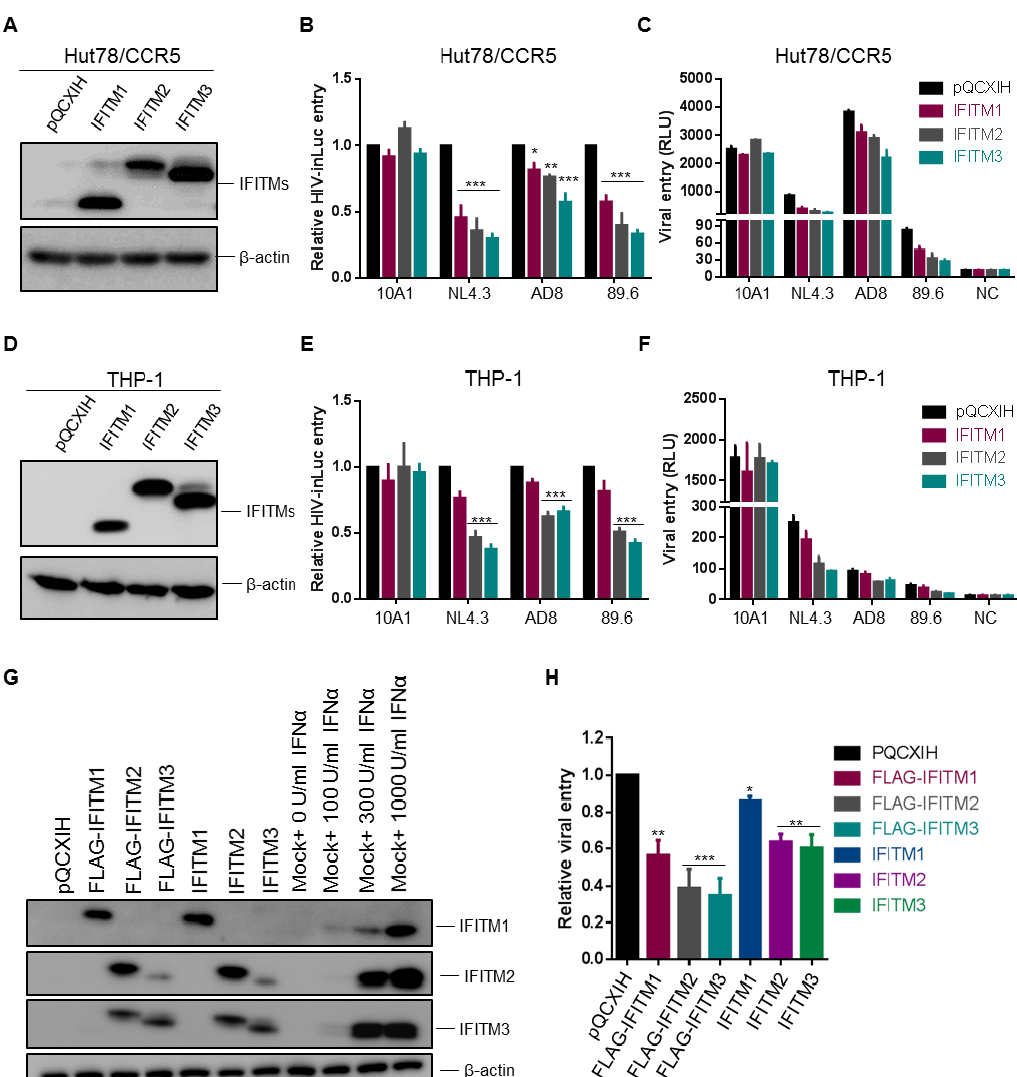
Figure 3. Ectopic expression of IFITM proteins in CD4+ HuT78 and THP-1 cells equivalently inhibits entry of HIV-1 CXCR4 and CCR5 isolates. Experiments were performed the same as described for Figures 1 and 2, except that HuT78 and THP-1 cells expressing individual IFITMs were used for infection. ( A ) IFITM1, 2, 3 expression levels in HuT78/CCR5 cells were examined by immunoblotting using an anti-FLAG antibody. ( B , C ) Infection of HIV-inGLuc bearing the Env of MLV 10A1, HIV-1 NL4.3, AD8 or 89.6, indicative of entry, in HuT78/CCR5 cells was shown. Relative entry efficiency was shown in ( B ) and absolute luciferase activities were plotted in ( C ). ( D ) IFITM1, 2, 3 expression levels in THP-1/CCR5 cells were examined by immunoblotting using an anti-FLAG antibody. ( E , F ) Infection of HIV-inGLuc bearing the Env of MLV 10A1, HIV-1 NL4.3, AD8 or 89.6, indicative of entry, in THP-1/CCR5 cells was presented. Relative entry efficiency was shown in ( E ) and absolute luciferase activities were plotted in ( F ). ( G ) Expression of FLAG-tagged and untagged wildtype (WT) IFITMs in SupT1 cells, as well as their comparisons with endogenous IFITMs in SupT1 cells induced by IFN α 2b treatment (0, 100, 300 and 1000 U/mL). β -actin served as loading control. ( H ) Effect of FLAG-tagged and WT IFITMs on HIV-1 NL4.3 inGLuc infection in SupT1 cells determined by gaussia luciferase activities 48 h after infection. Data are mean ± SD from at least three independent experiments; * p < 0.05, ** p < 0.01, *** p <